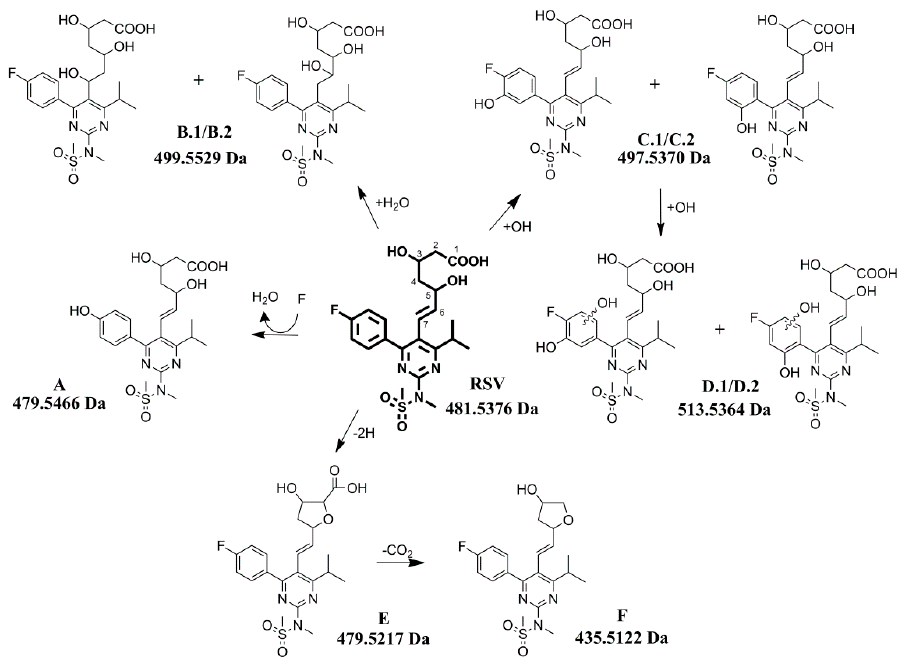
Figure 1. Structures and belonging molecular weights in Da of rosuvastatin (RSV) molecule and degradation products induced by radiation dose up to 1000 Gy: A, B.1/B.2, C.1/C.2, D.1/D.2, E, and F.